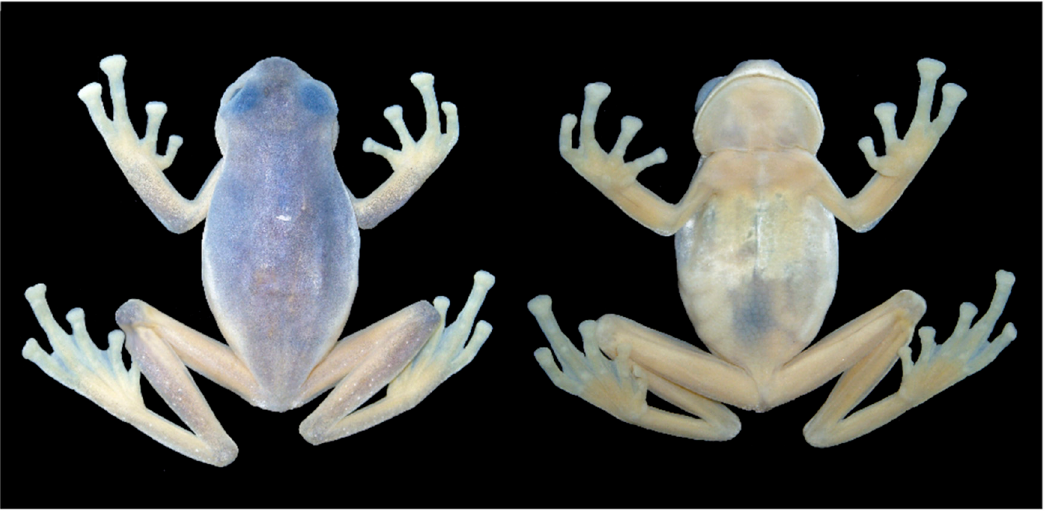
Figure 27. Centrolene buckleyi , adult female, neotype, KU 220770. Ecuador, Imbabura province, Isla Grande, Lago Cuicocha, 3070 m. Photos by Juan M. Guayasamin. Grande, Lago Cuicocha, 3070 m. Photos by Juan M.